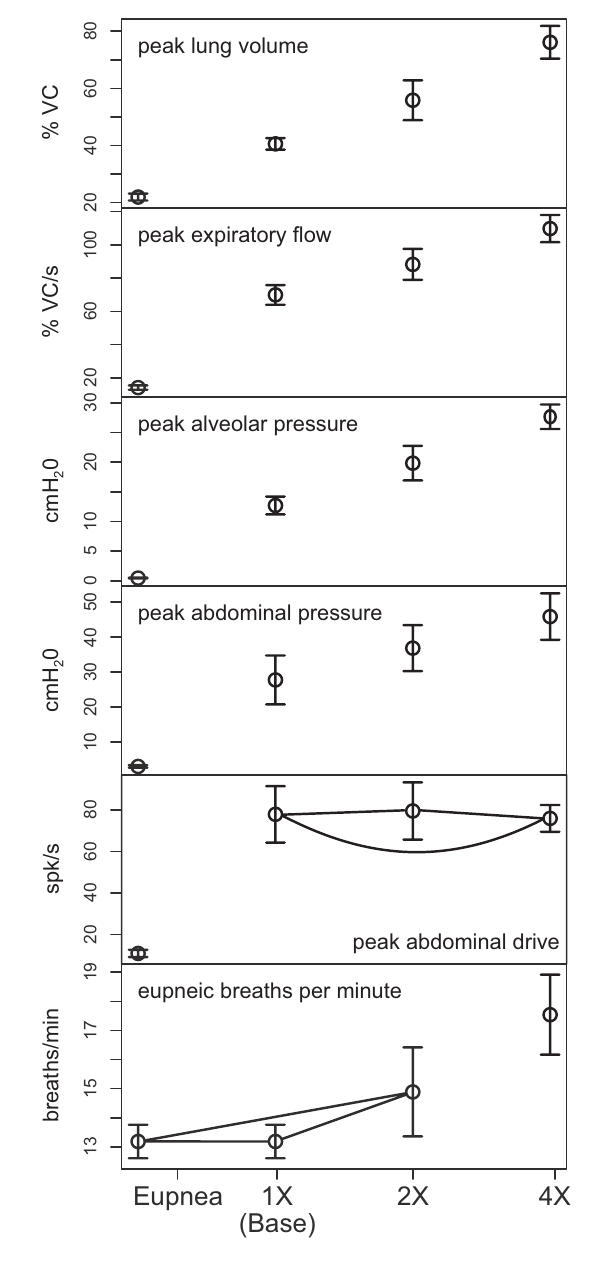
FIGURE 4 | Means of peak values ( ± 95% confidence limits) of (from top) lung volume, expiratory tracheal flow, alveolar pressure, abdominal pressure, and abdominal drive together with respiratory cycle frequencies during pre-cough eupneic intervals (bottom) measured during model simulations of baseline cough (1 × ) and two conditions of increased phrenic-to-diaphragm activation gain (2 × , 4 × ). Pairs of symbols connected by a line indicate no significant